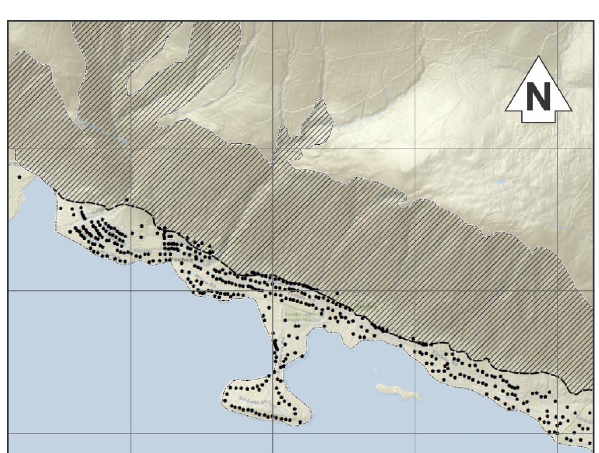
Figure 20. Modeled debris flow runout limit. Note that most of the 240 properties (black pentagons) are outside the modeled runout zone. Background image © ESRI World Topographic Map.